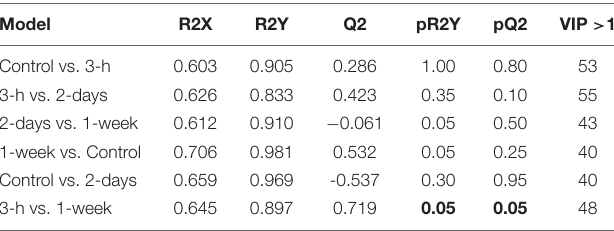
TABLE 5 | Supervised multivariate PLS-DA models computed from metabolites found in urine metabolome differentiating two